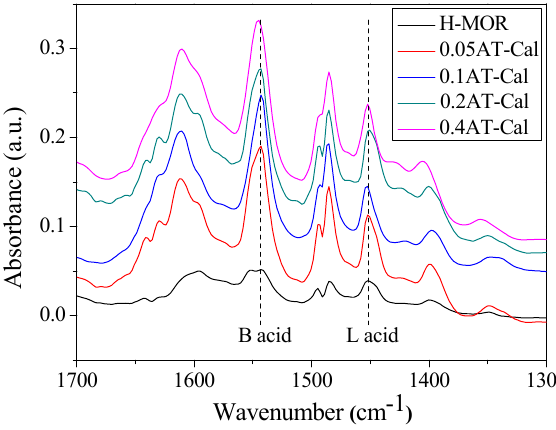
Figure 4. NH 3 -TPD spectra of the samples before and after alkali treatment.